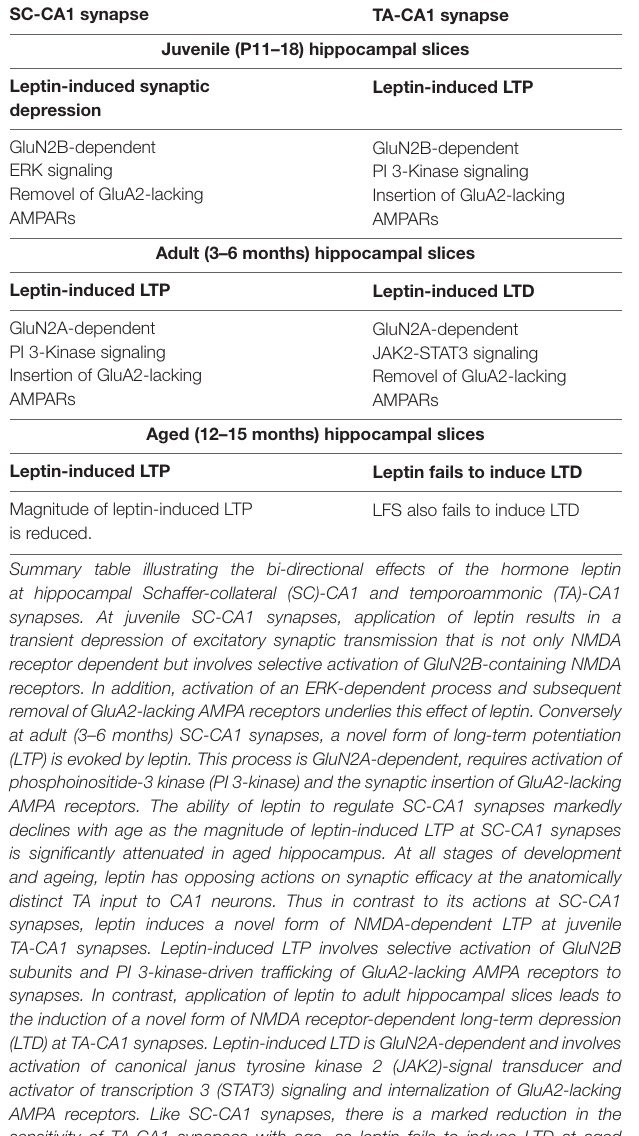
TABLE 1 | Summary of the opposing actions of leptin at hippocampal synapses with age. SC-CA1 synapse